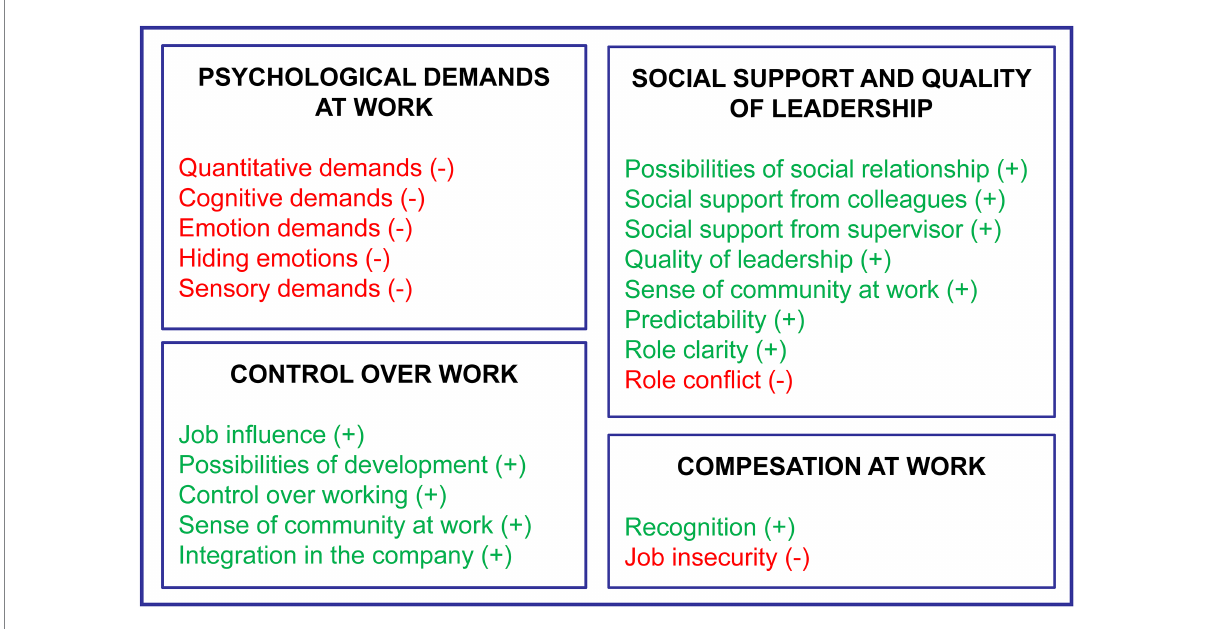
FIGURE 1 Psychosocial dimensions of the COPSOQ